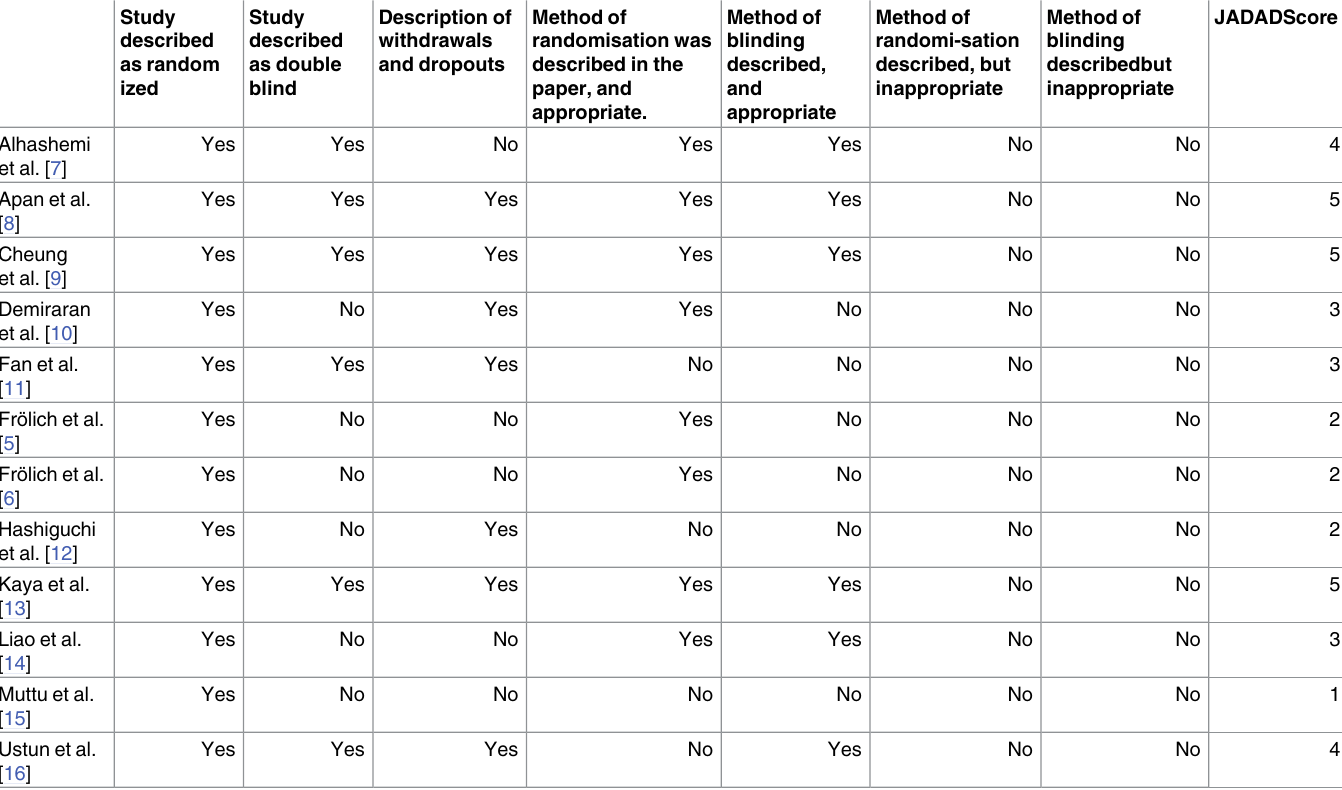
Table 2. Jadad scores for included